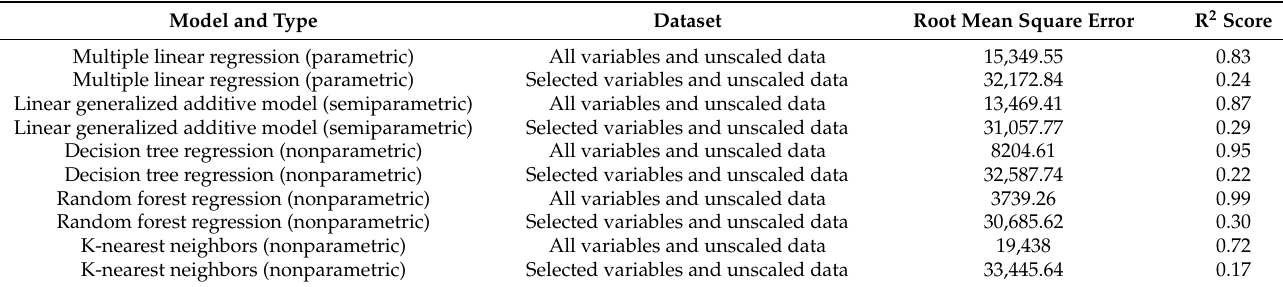
Table 3. Performance of multiple linear regression, linear generalized additive, decision tree, random forest and K-nearest neighbors in terms of root mean square error and R 2 .